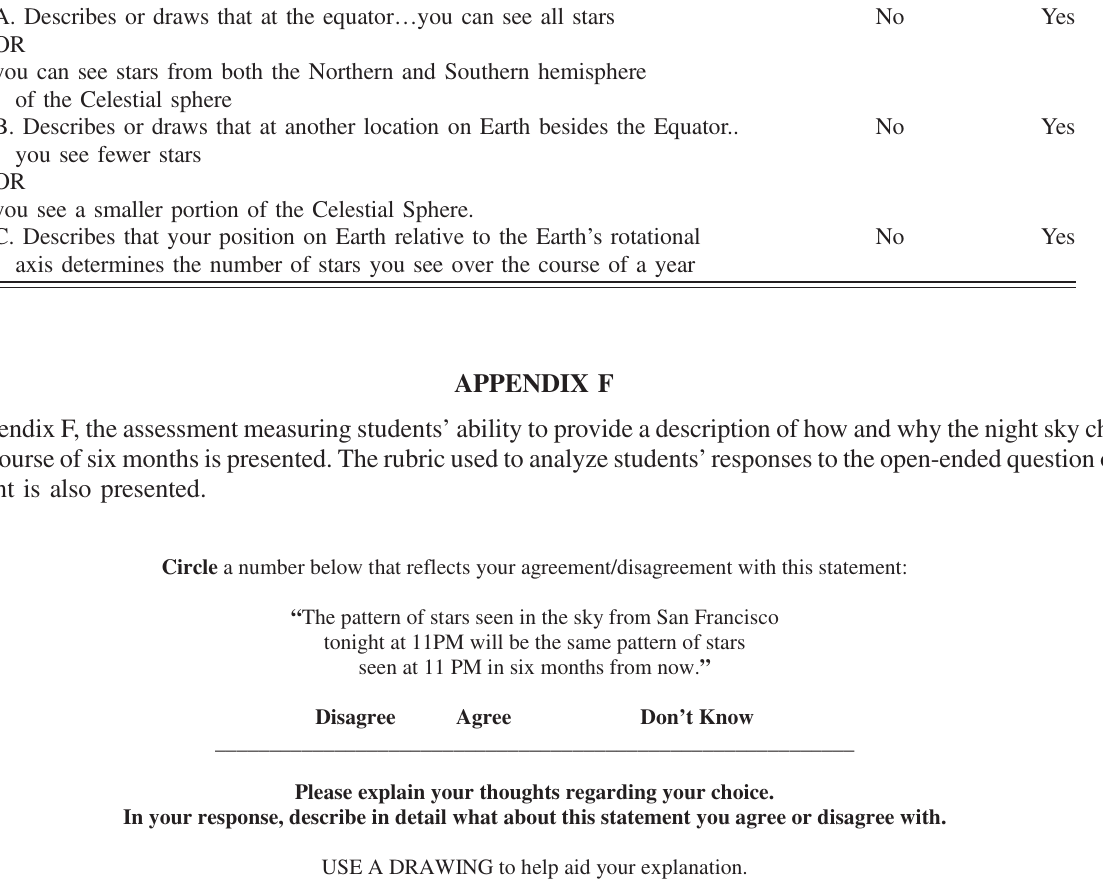
FIG. 11. Assessment used to measure students ’ ability to identify the portion of the celestial sphere that is visible from various locations on Earth. The distributions of students choosing the correct multiple-choice response and attaining the minimum rubric score can be found in Fig. 4. This question was adapted from Paul Green ’ s Peer Instruction for Astronomy